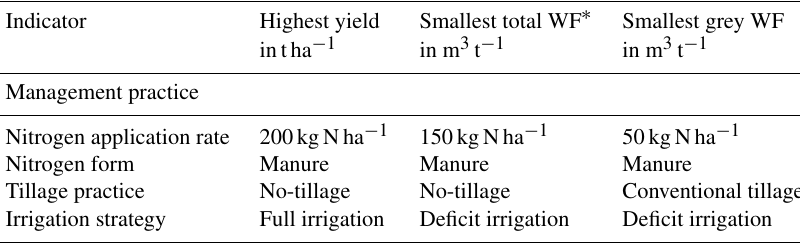
Table 2. The measures that give the optimum grey WF per tonne, total WF per tonne or yield. Indicator